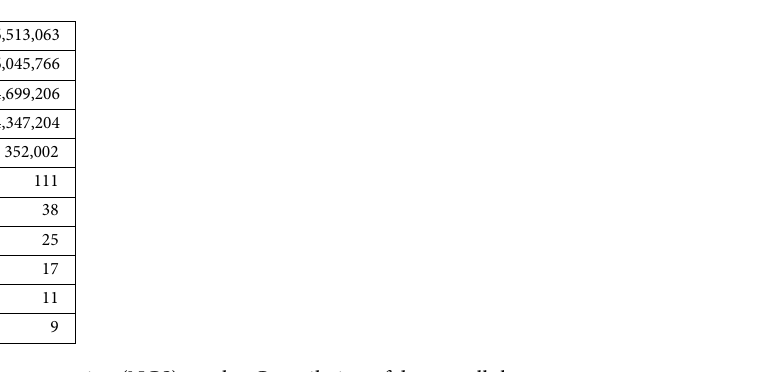
Table 1. Next-generation sequencing (NGS) results. Compilation of data on all the aptamer sequences obtained by